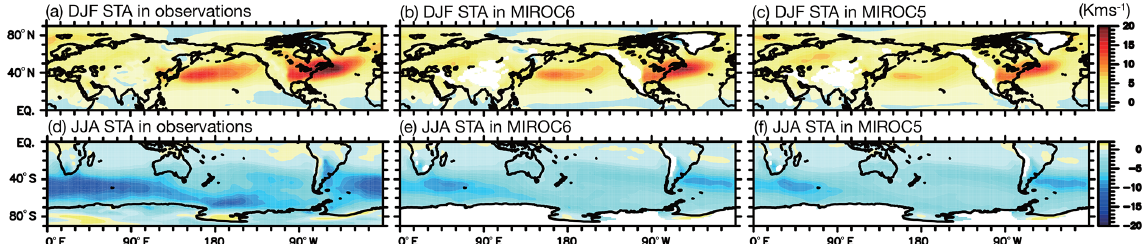
Figure 11. Wintertime storm track activity (STA) in observations (a, d) , MIROC6 (b, e) , and MIROC5 (c, f) . STA is defined as 8d high- pass-filtered eddy meridional temperature flux at the 850hPa pressure level. Maps for boreal and austral winter are shown in (a–c) and (d–f) , respectively. ERA-I is used as